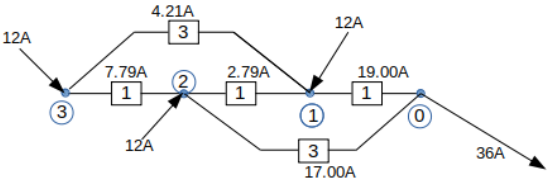
Figure 3. As Fig 2. but with a different distribution of currents, being maximized at 20A per